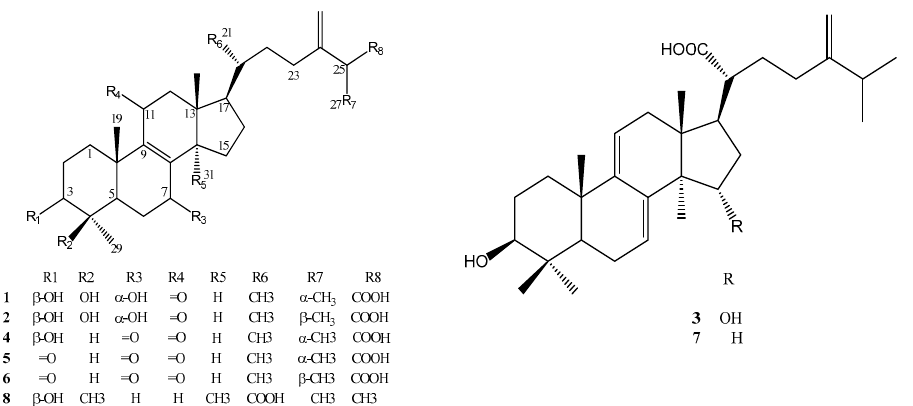
Figure 2. Chemical structures of purified active compounds. 25 S -antcin K ( 1 ), 25 R -antcin K ( 2 ), dehydrosulphurenic acid ( 3 ), 25 S -antcin I ( 4 ), 25 S -antcin B ( 5 ), 25 R -antcin B ( 6 ), dehydroeburicoic acid ( 7 ) and eburicoic acid ( 8 ).